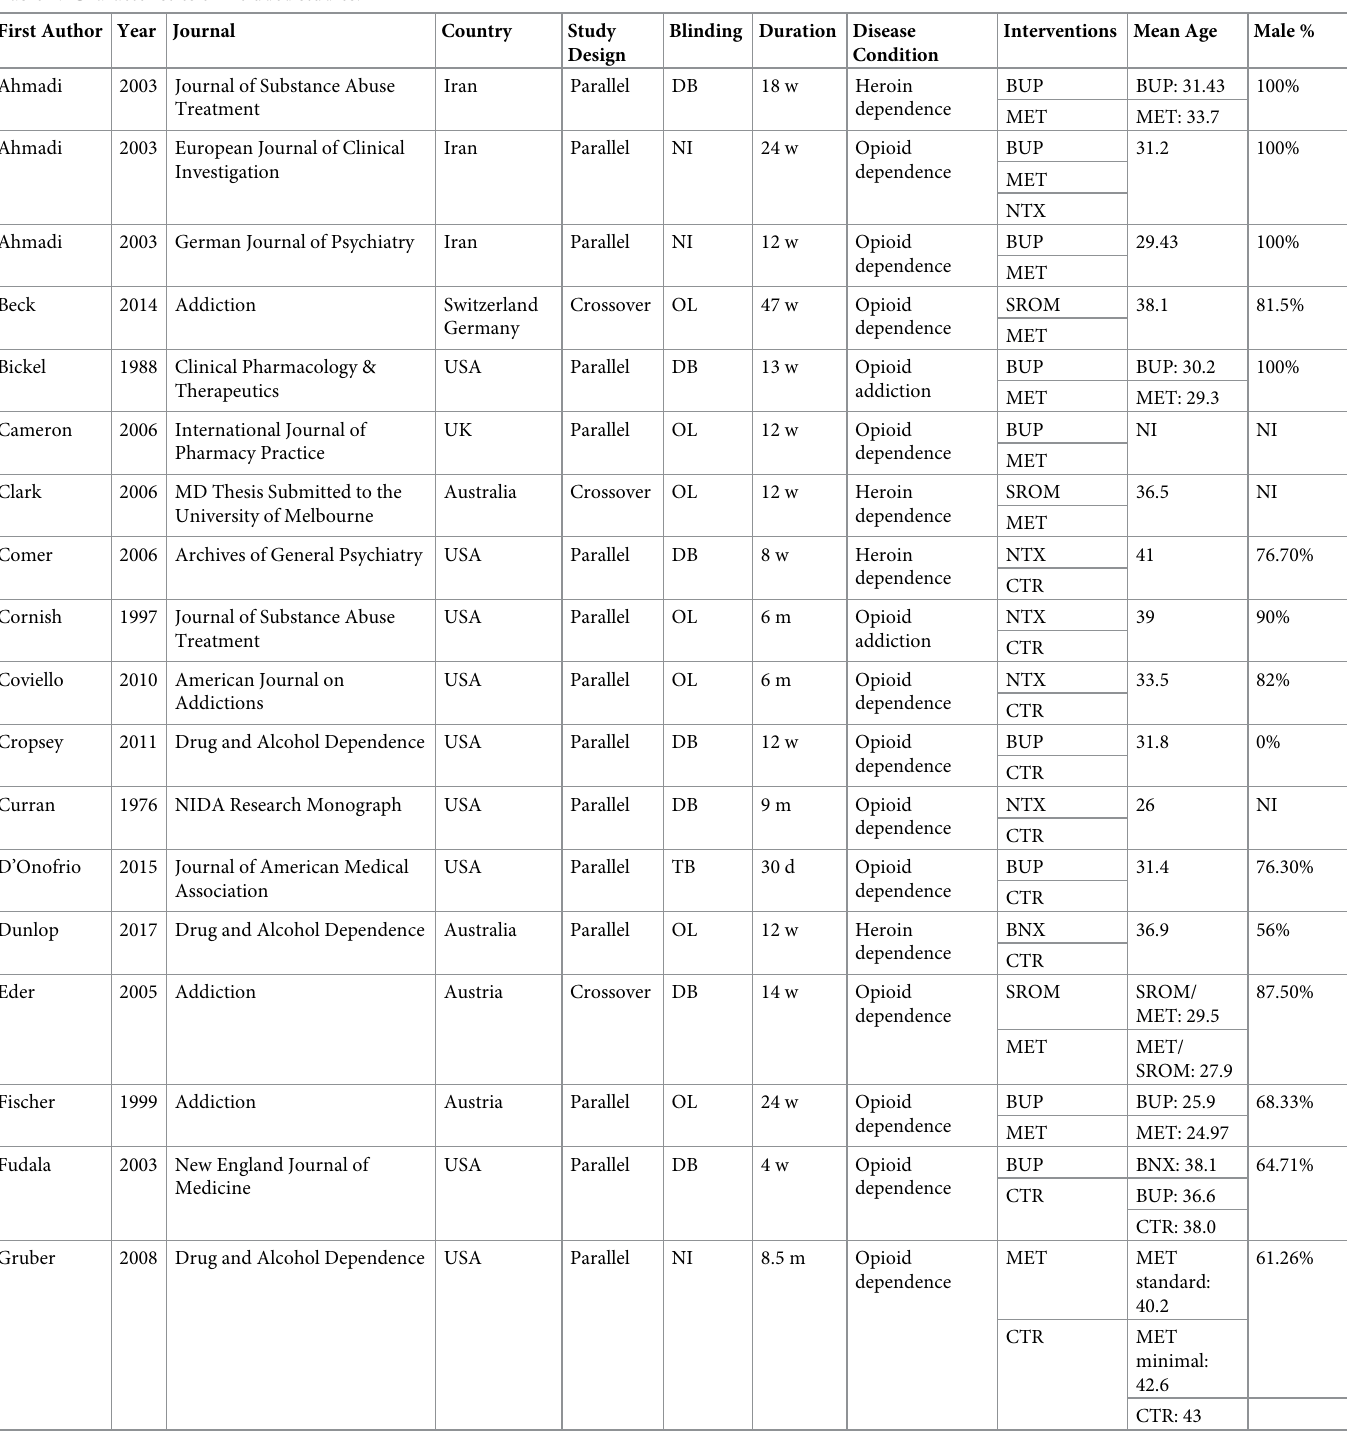
Table 1. Characteristics of included